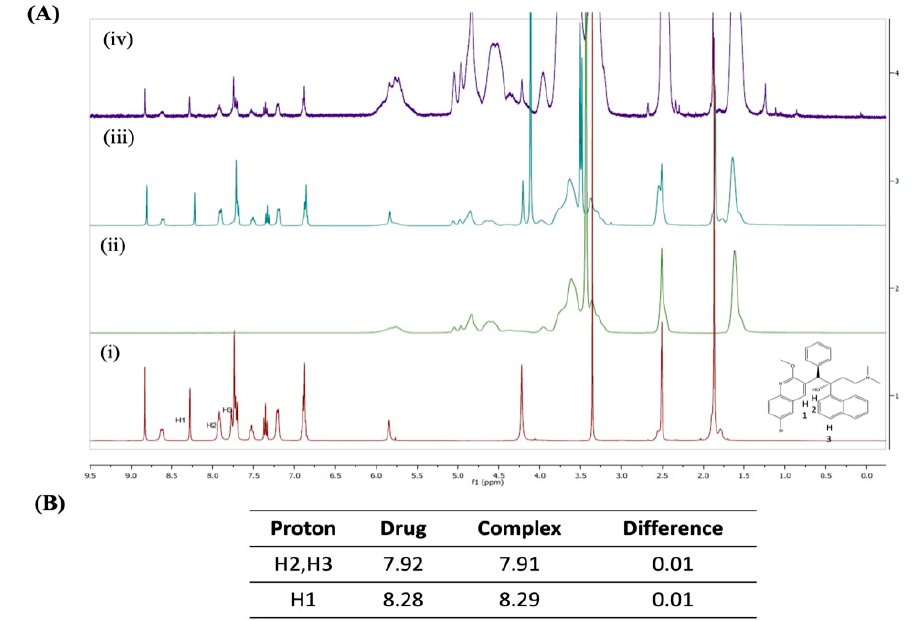
Figure 2. ( A ) NMR spectra of bedaquiline (i), SBE- β -CD (ii), the physical mixture of bedaquiline and SBE- β -CD (iii), and the inclusion complex BDQ-CD (iv). ( B ) Summary table for NMR chemical shift values.